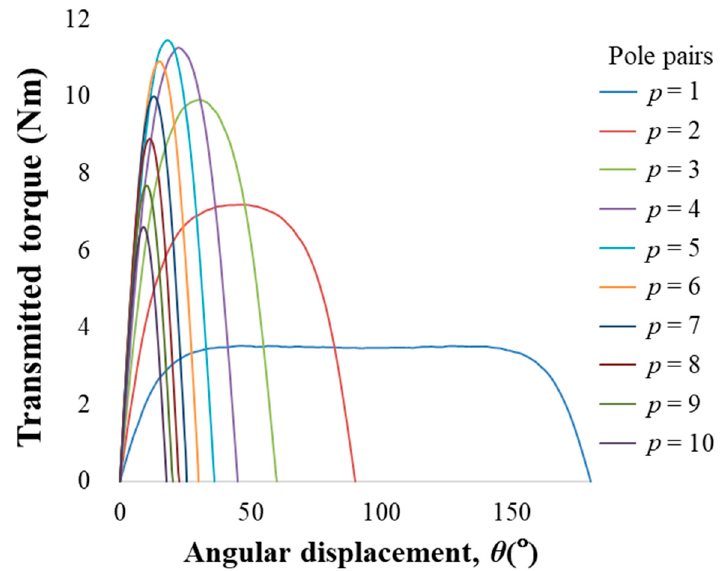
Figure 8. The transmitted torque of the magnetic couplings with different pole pairs.